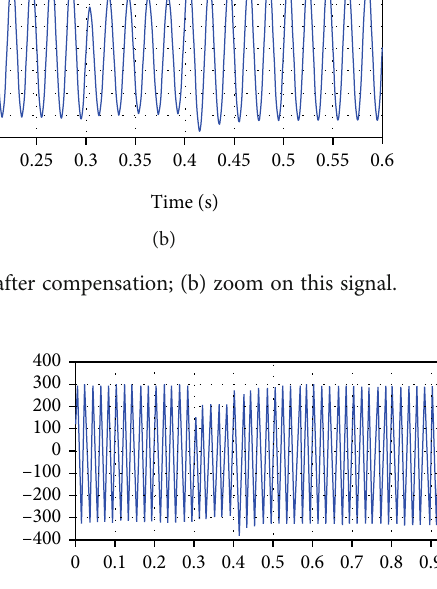
at the terminals of sensitive load after L